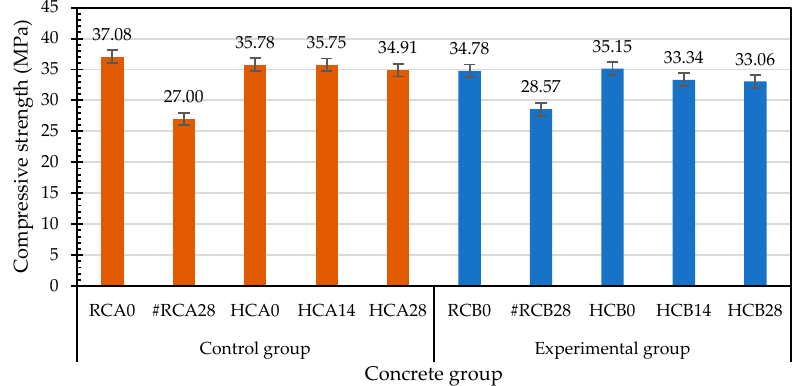
Figure 18. Effects of different test parameters on the compressive strengths of concrete.